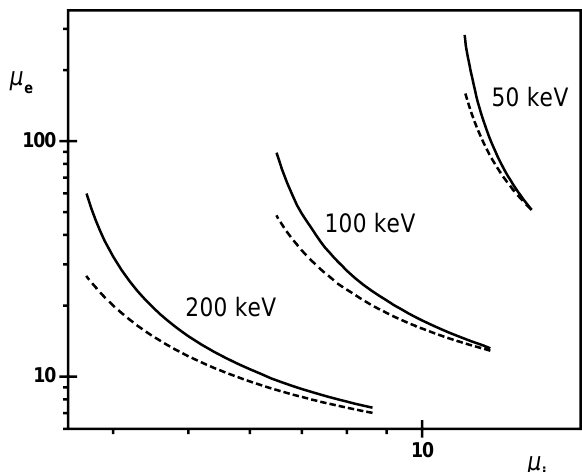
FIG. 4. Range of temperature parameters m e and m i for which stable solutions can be found at the studied energies. The solid curves are at the limit of stability with high beam compres- sion; below the dashed curves the beam will be decompressed ( f e , 1 ).